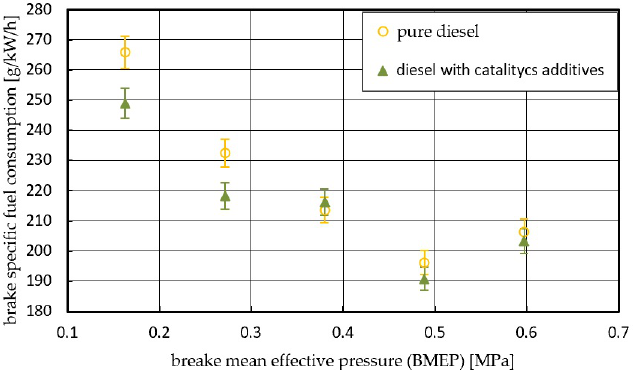
Figure 3. Brake-specific fuel consumption vs. brake mean effective pressure for pure diesel and fuel with catalytic additive at an engine speed of 2000 rpm.